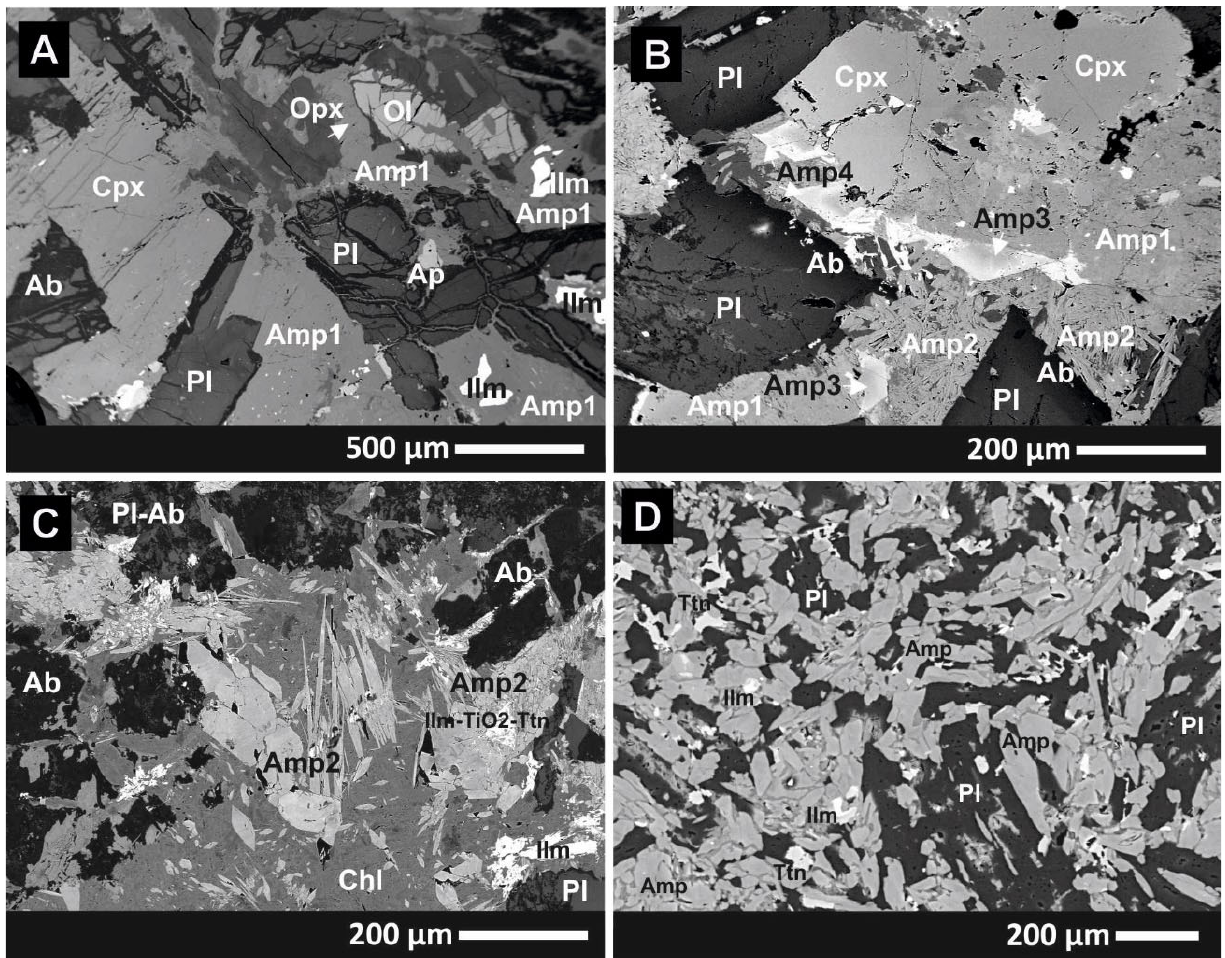
Figure 17. BSE images of dolerites ( A – C ) and a basalt ( D ). ( A ) Ol ‐ Opx ‐ Cpx ‐ Pl ‐ Amp dolerite (P9). ( B ) Cpx ‐ Pl ‐ Amp ‐ Ilm dolerite (P17C) with the primary Amp1 and the secondary Amp2–4 types. ( C ) Cpx ‐ Pl ‐ Amp ‐ Ilm dolerite (P13C) with the secondary Amp2, Chl, Ab, TiO2 a Ttn. ( D ) Amp ‐ Pl ‐ Ilm basalt (P10D).